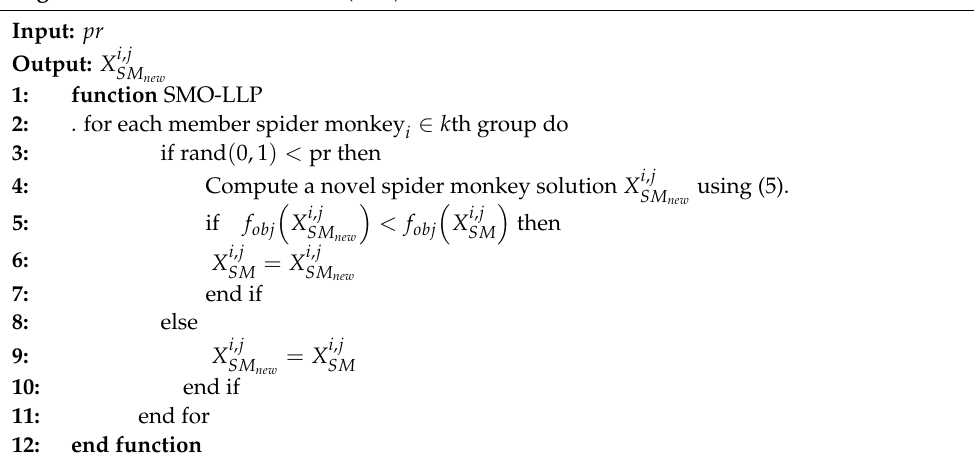
Algorithm 1: Local Leader Phase